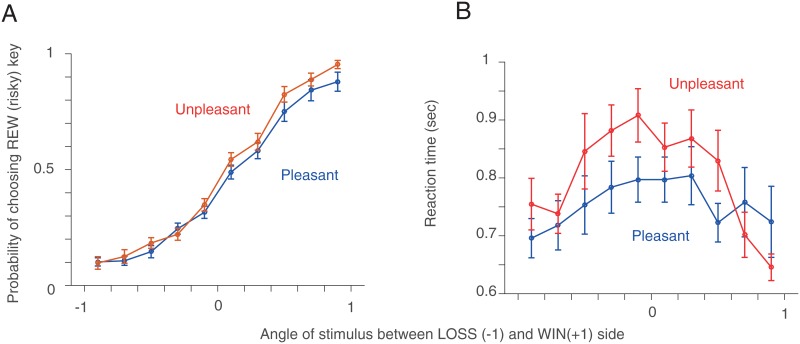
Model-agnostic results (Session 3).A. The probability of choosing the REW (risky) key in Session 3. The red (blue) line indicates the mean and the SEM of participants in the Unpleasant (Pleasant) condition. B. Reaction time (RT). Note that this session has 250 different stimulus ambiguities for each participants. We binned conditions with the width of s = 0.2.